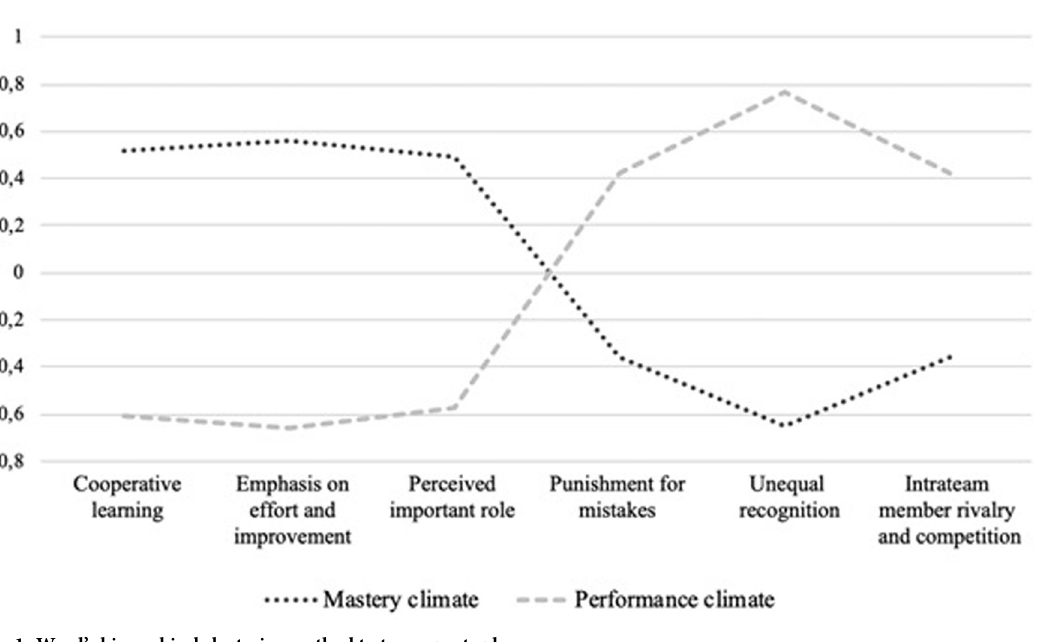
Fig 1. Ward’s hierarchical clustering method to team sports